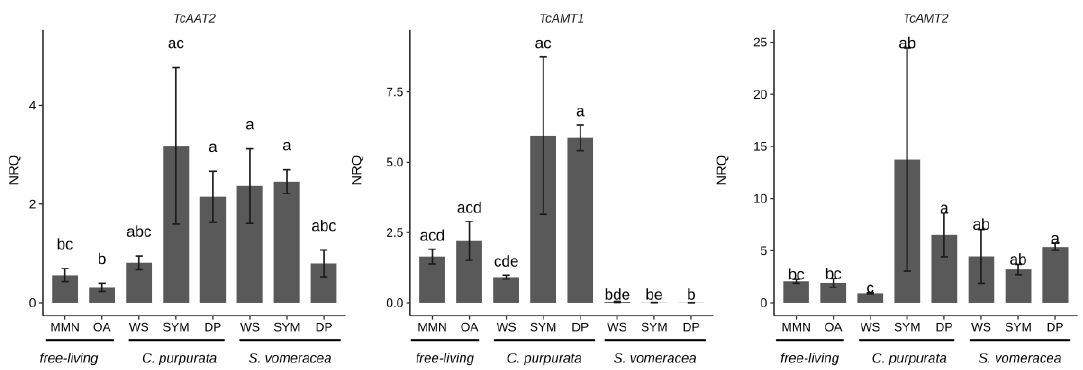
Figure 5. T. calospora symbiosis marker genes in C. purpurata and S. vomeracea orchid mycorrhiza interactions. Letters indicate significant differences after Kruskal-Wallis test and Dunn’s post-hoc test ( p < 0.05). NRQ, normalized relative quantities; mean ± standard error (SE) is plotted.